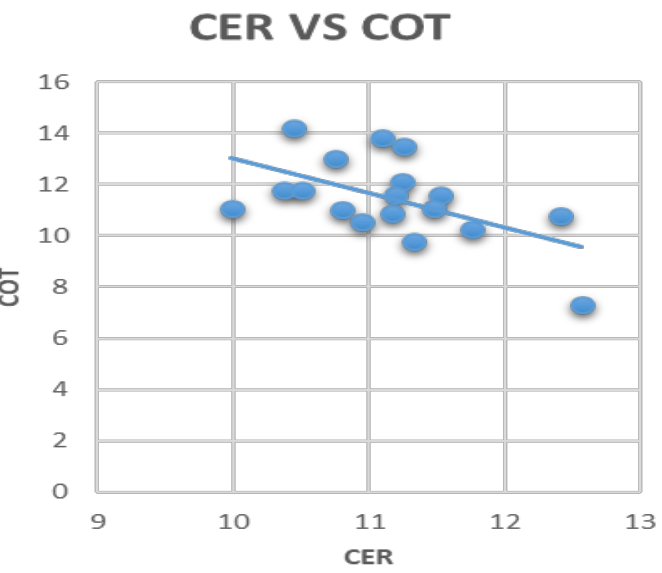
Figure 9. Scatter plot of CER vs. AAI and CER vs. COT over Assab in July shows the correlation plot of highlighted bold values given in Table 9.